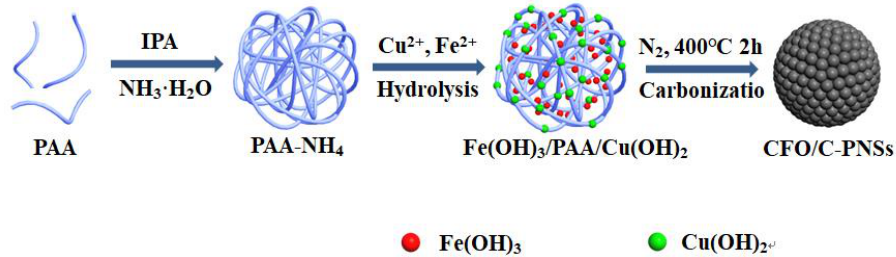
Figure 1. Schematic illustrating the synthesis process of the CFO/C-PNSs sample.